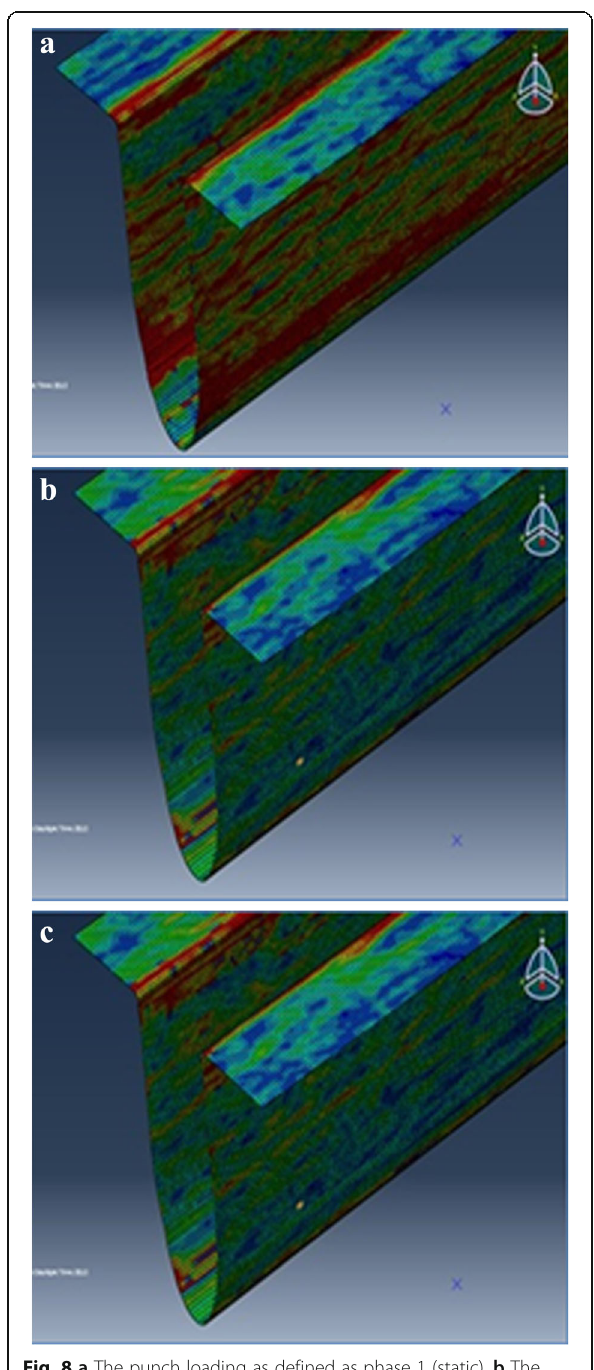
Fig. 8 a The punch loading as defined as phase 1 (static). b The punch loading as defined as phase 2 (explicit dynamic). c Unloading of the sheet